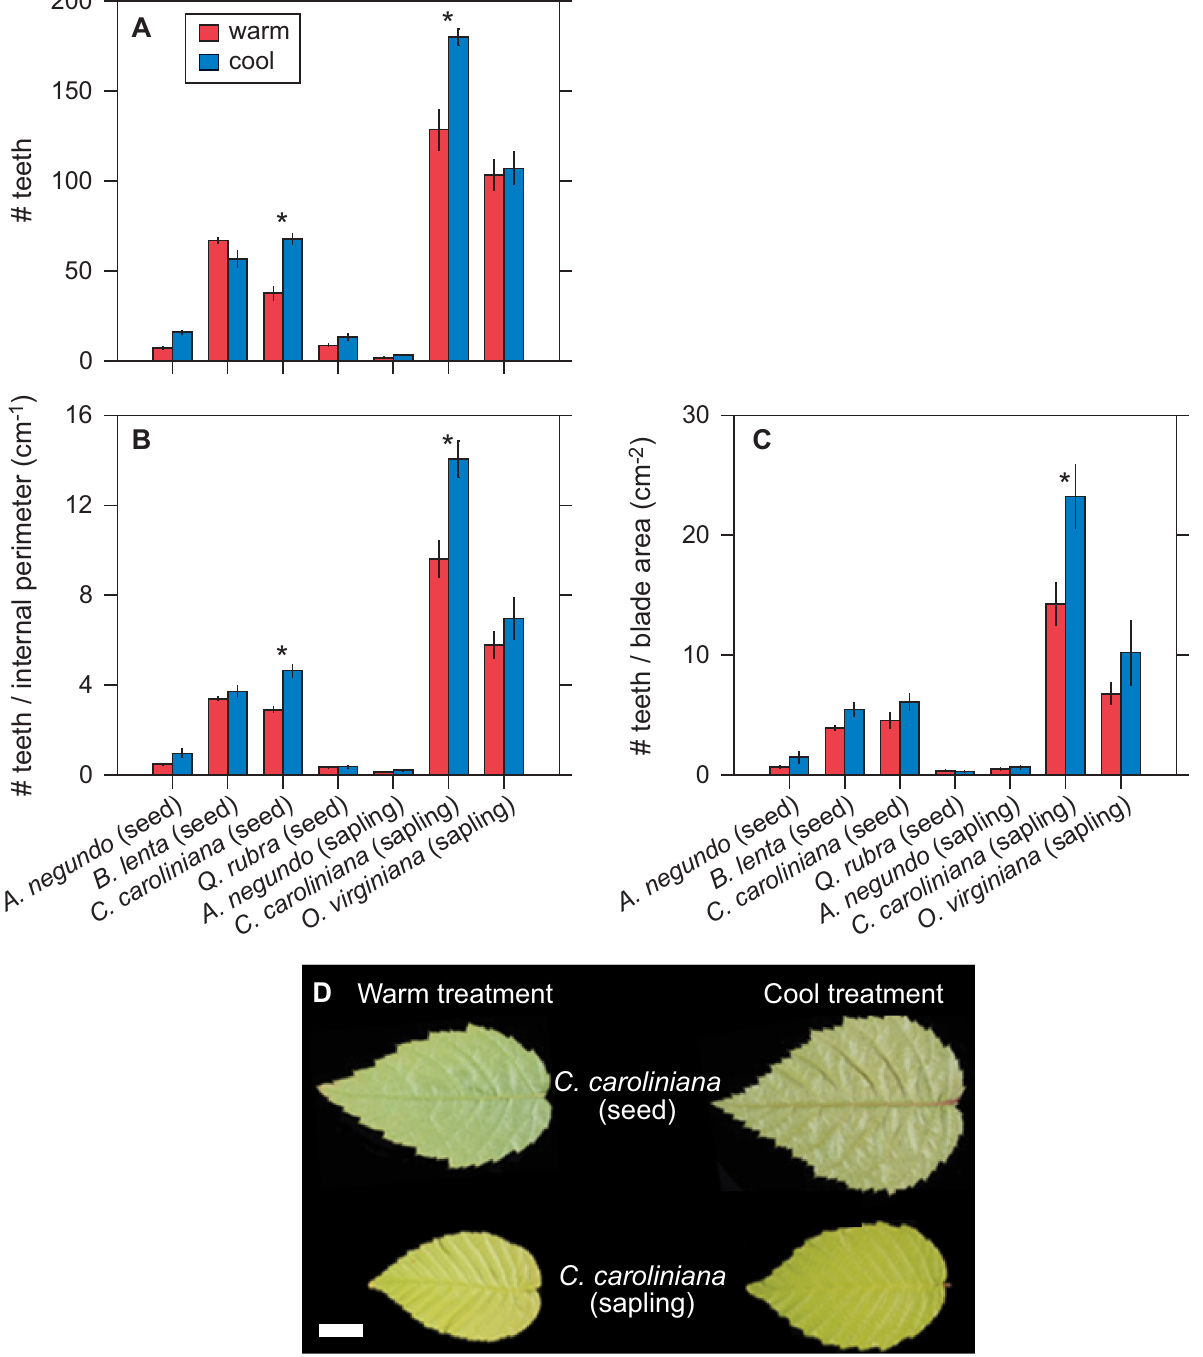
Fig 1. Sensitivity of tooth abundance variables to temperature. (A-C) Comparisons of the species grown in the growth cabinet experiment for tooth abundance variables. Values are means ± 1 s.e.m. � indicates a significant difference ( P < 0.05) based on estimated marginal means (see Materials and Methods). Global site-based patterns [6] would predict higher values in the cool treatment for all variables. (D) Representative leaves from species in this experiment that show significant differences in tooth abundance between the two treatments. Scale bar = 1